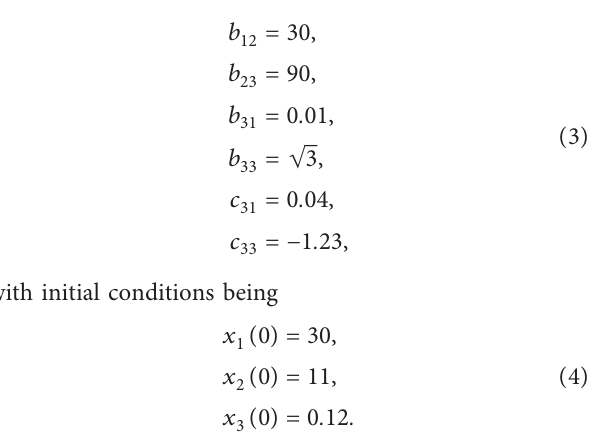
Figure 5 (1) state variable ( x ( t ) , x ( t ) , x ( t )) , respectively, against time t 1 2 3